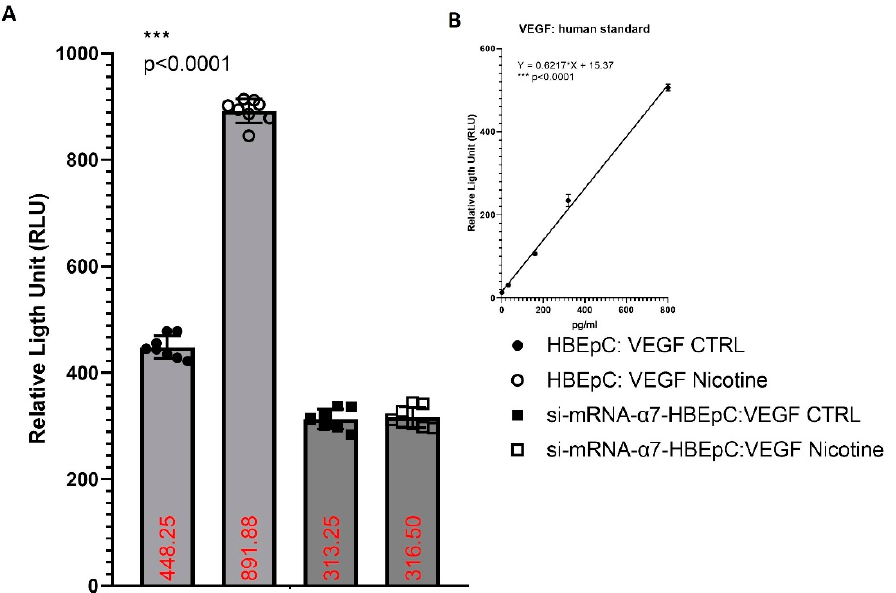
Figure 11. Induction of VEGF by nicotine in HBEpC and/or si-mRNA- α 7-HBEpC. A : ELISA exper- iments; B regression equation linearity for VEGFR. Statistical significance is analyzed with one- way AOVA with multiple-comparison and post hoc test with Bonferroni correction. Experiments are performed at least two times in triplicate.